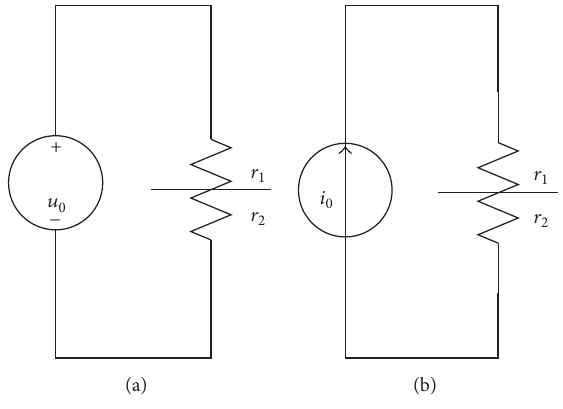
Figure 3: Two simple electrical